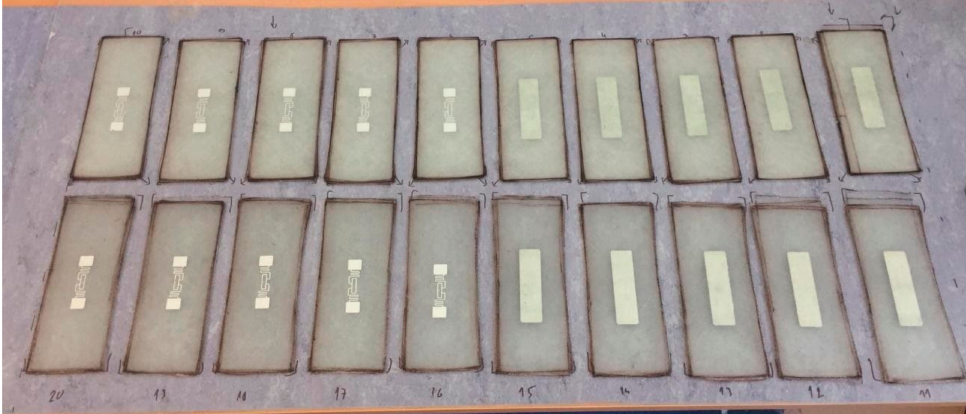
Figure 4. Storage of individual samples during the lamination process on a glass